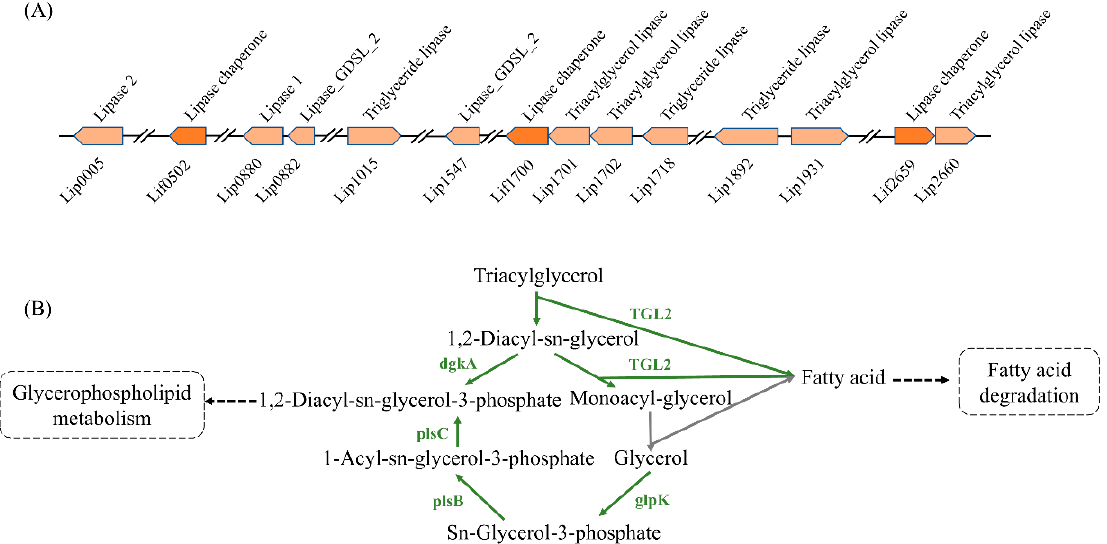
Figure 4. The pan-genome analysis and genome phylogenetic tree of strains belonging to A. junii : ( A ) petal diagram of the pan-genome showing the number of core genes of the species in the center and the number of petals corresponding to the specific genes of each A. junii strain; ( B ) phylogenetic tree constructed using the neighbor-joining method based on 2229 core protein genes.